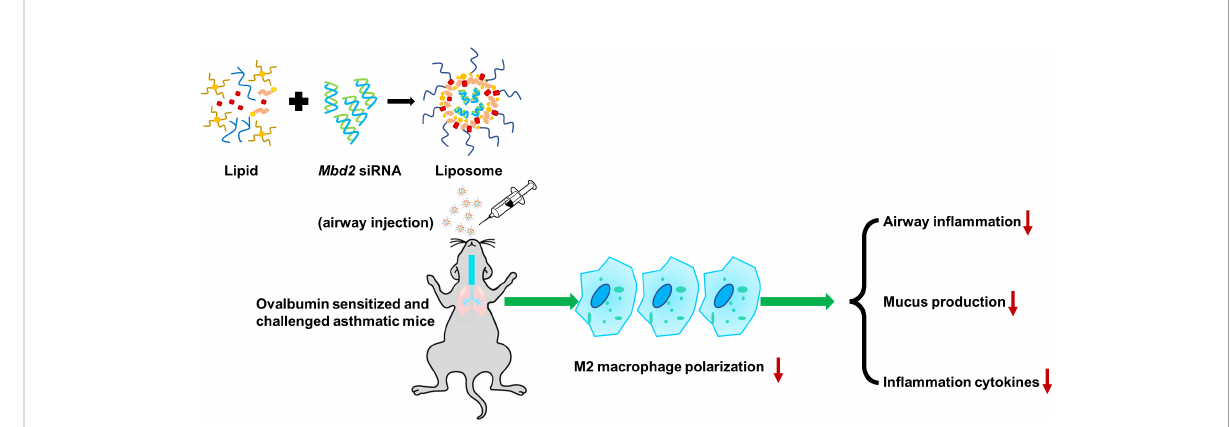
FIGURE 7 Schematic illustration of the protective effects of silencing Mbd2 in OVA-induced allergic airway in fl ammation through attenuating the macrophage M2